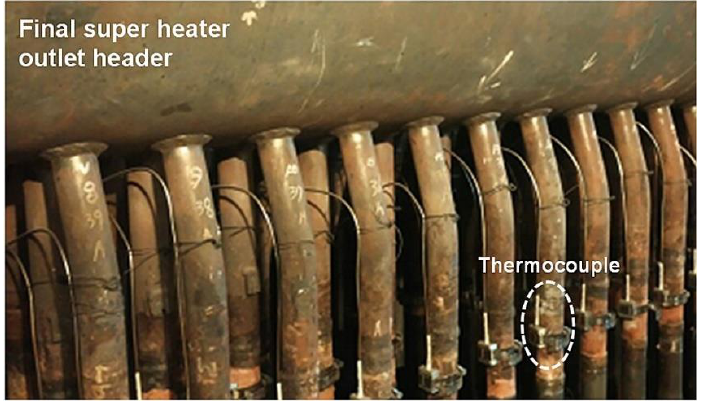
Figure 11. K-type thermocouples affixed to each tube in the outlet header section using banding [112].